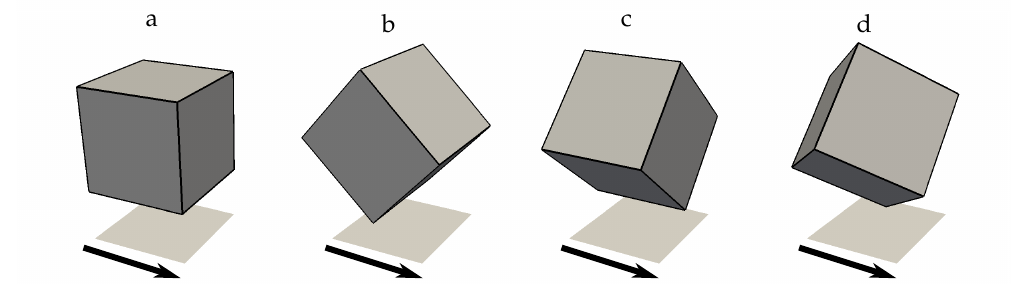
Figure 12. Illustration of the impact of the cube presenting its face ( a ), edge perpendicular ( b ) and parallel ( c ) to the tangential velocity and its corner ( d ). The arrows represent the tangential